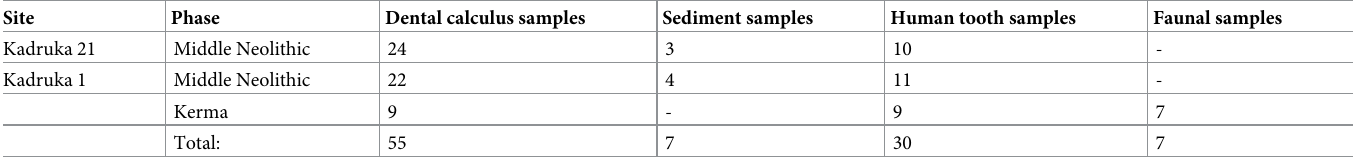
Table 1. Analysed samples from KDK21 and KDK1.